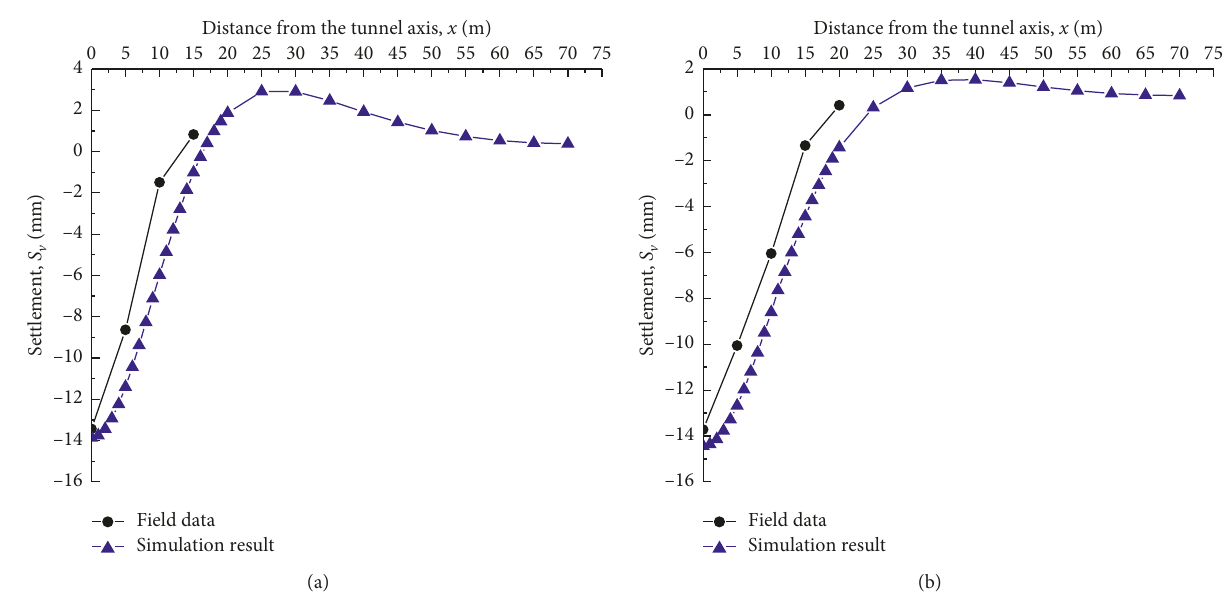
Figure 18: Surface settlement troughs comparison between simulation results and field data: (a) DK17 +885; (b) DK17 +400.